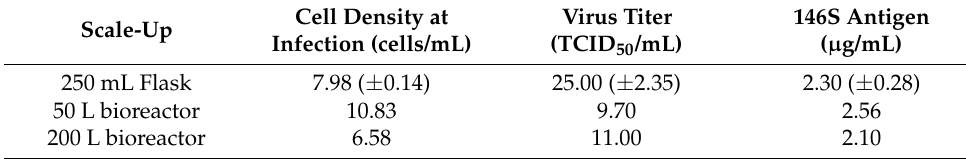
Table 2. Scaled-up production of